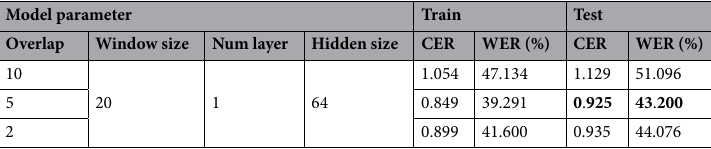
Table 5. Overlap tuning experiment result. Significant values are in